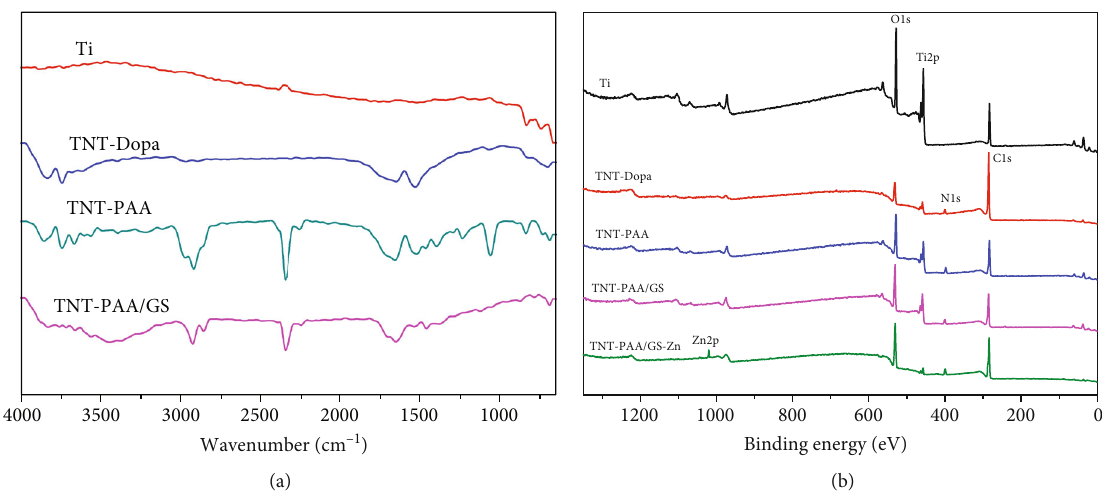
Figure 2: The ATR-FTIR spectra (a) and XPS spectra (b) of the di ff erent samples. Table 1: The surface element concentration of the di ff erent samples measured by